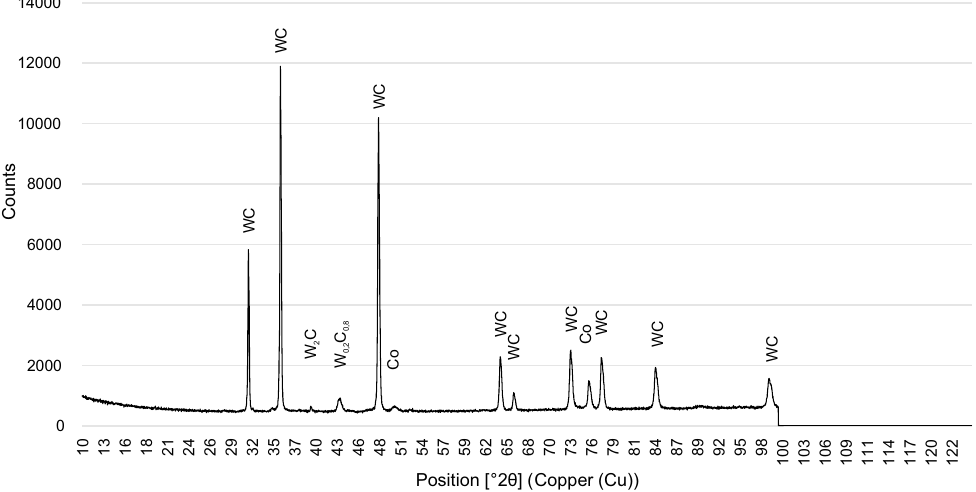
Figure 5. Phase composition of particles of AW701 powder mixture. EDS analysis found that the particles contain 13 ± 0.6 wt.% of Co binder. The particle size of α -phase was 3.0 ± 1.9 µm